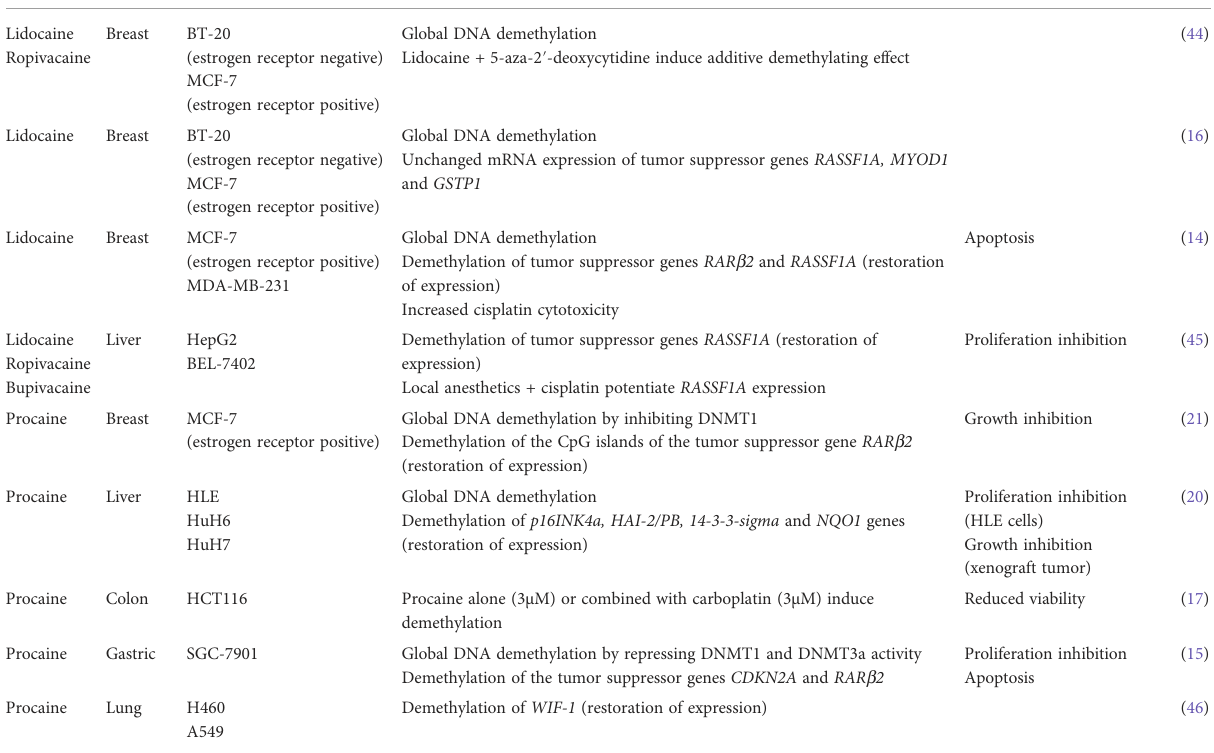
TABLE 1 Local anesthetics and DNA